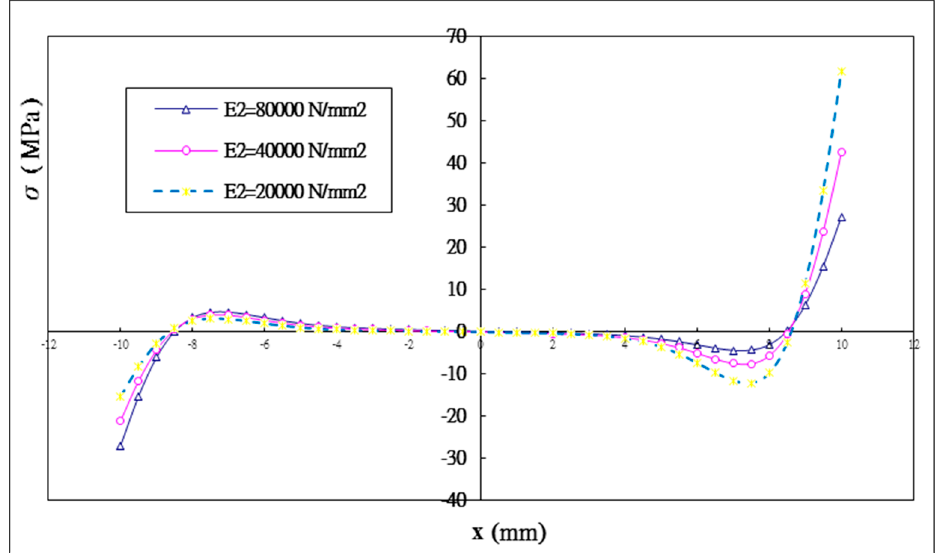
Figure 14. Peel stress distribution in the adhesive with three different Young’s moduli of the inner adherend.